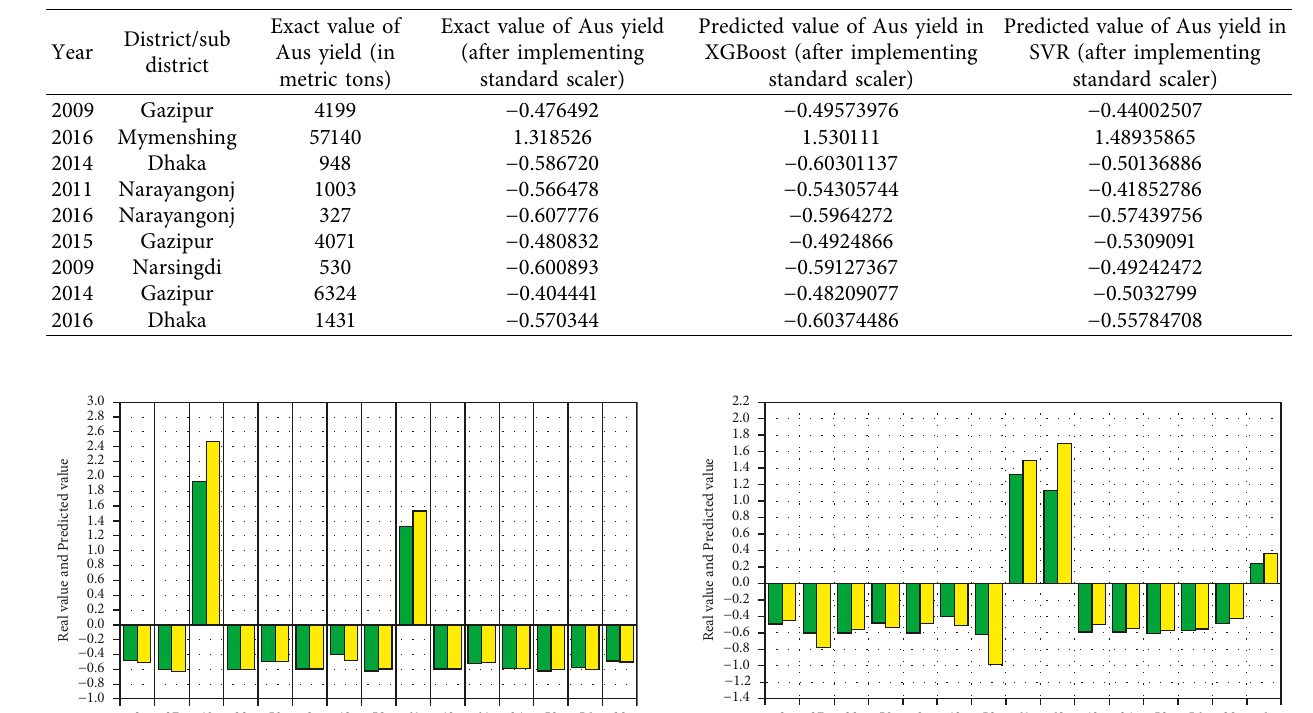
Table 2: The exact value and the predicted value of Aus yield in the different districts in different years.